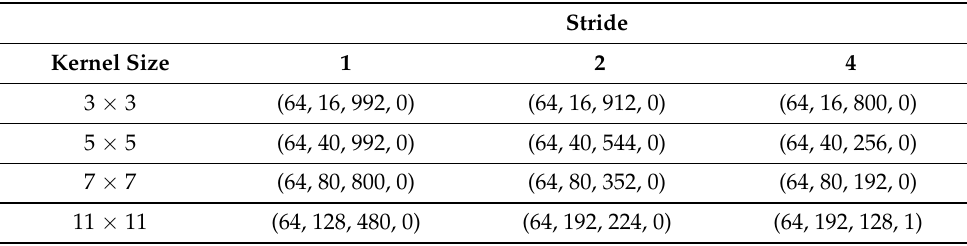
Table 2. The optimal computation scheme of convolution under different convolution kernels and different strides.